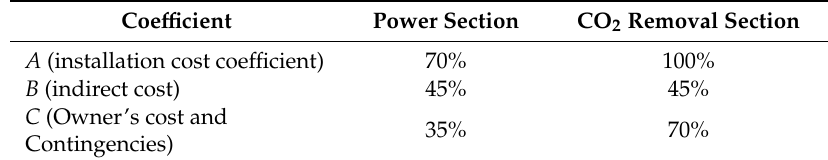
Table 6. Coe ffi cient for Total Plant Cost